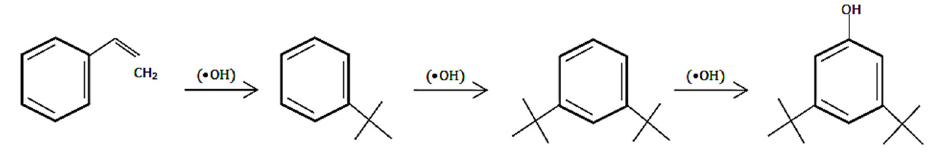
Figure 14. Reaction mechanism of styrene.